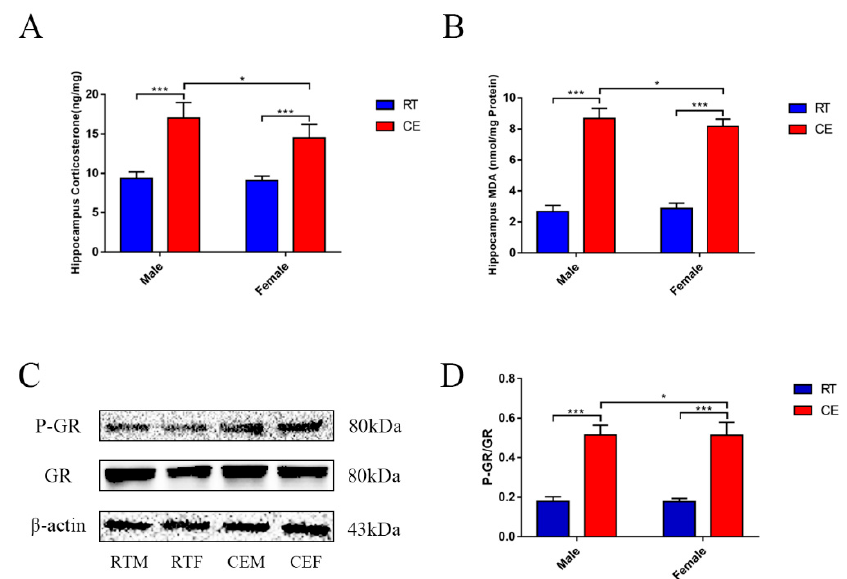
Figure 1. Hippocampus cortisol (CORT) levels of male and female mice at room temperature in the (Cold exposure) CE group ( A ). Data analyses involving di ff erent treatments and sex groups used the two-way analysis of variance. The results are expressed as the mean ± SD ( n = 10) in 10 independent experiments; * p < 0.05; *** p < 0.001. The levels of Determination of Malondialdehye (MDA) were measured in hippocampus lysates after cold exposure ( B ). The results are expressed as the mean ± SD ( n = 5) in five independent experiments; * p < 0.05; *** p < 0.001. The relevant expressions of anti-oxidative proteins and markers of neuronal dendritic tissue in hippocampus lysates as assessed by western blotting and relative density analyses ( C ) of glucocorticoid receptor (GR), phospho-glucocorticoid receptor (P-GR) and β -actin expression in each group. Expression levels were quantitated by measuring band intensities using Image Lab software. The graphs indicate densitometric analyses using the expression ratios of ( D ) GR / P-GR. Data were between room temperature male (RTM) vs. cold exposure male (CEM), room temperature female (RTF) vs. cold exposure female (CEF) phosphorylation levels, and CEM vs. CEF, and were analyzed by two-way analysis of variance. The results are expressed as the mean ± SD ( n = 6) of four independent experiments; * p < 0.05; *** p < 0.001.